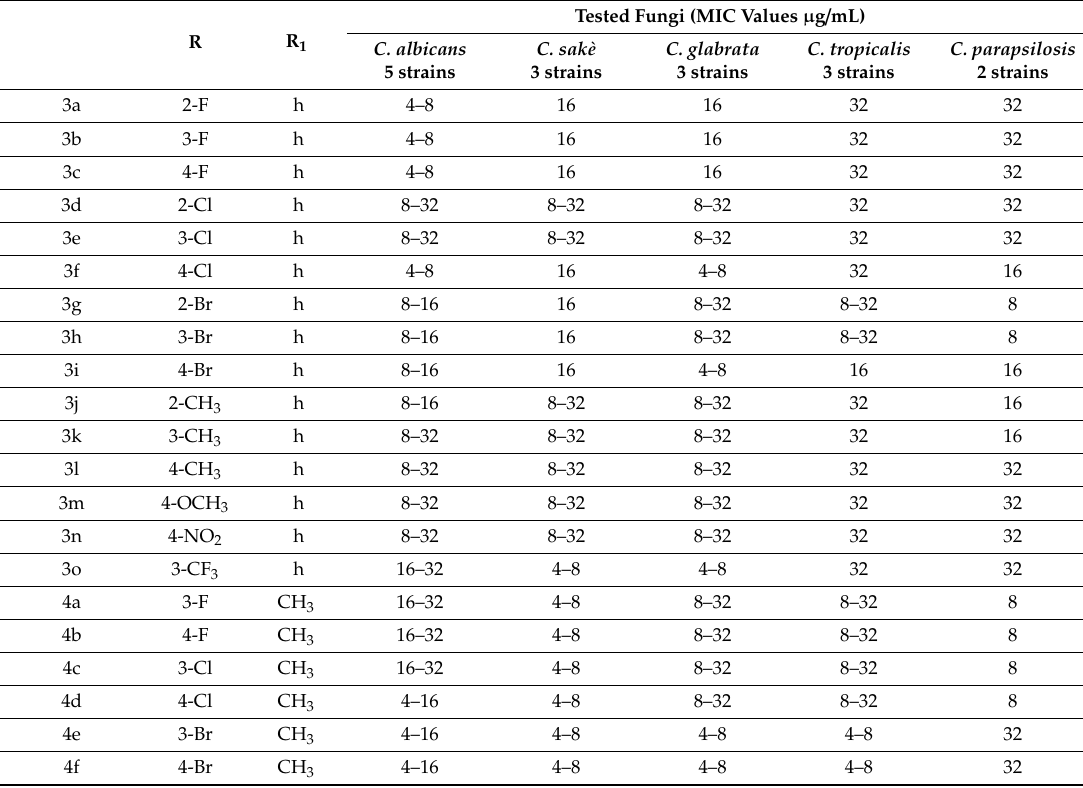
Table 1. Minimum inhibitory concentration (MIC) of newly synthesized compounds (3a–3o and 4a–4k), clotrimazole, and fluconazole against sixteen clinical strains of Candida